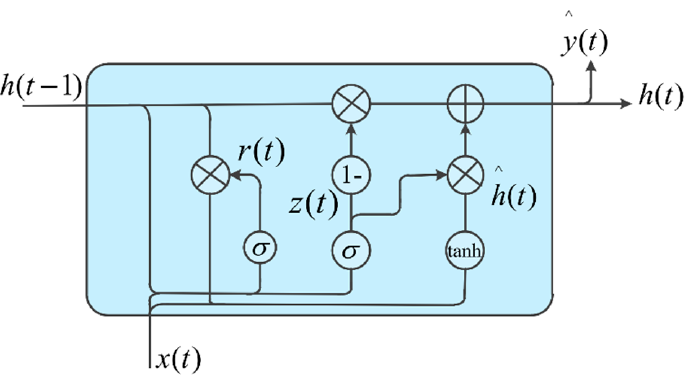
Figure 4. The structure of the GRU network.